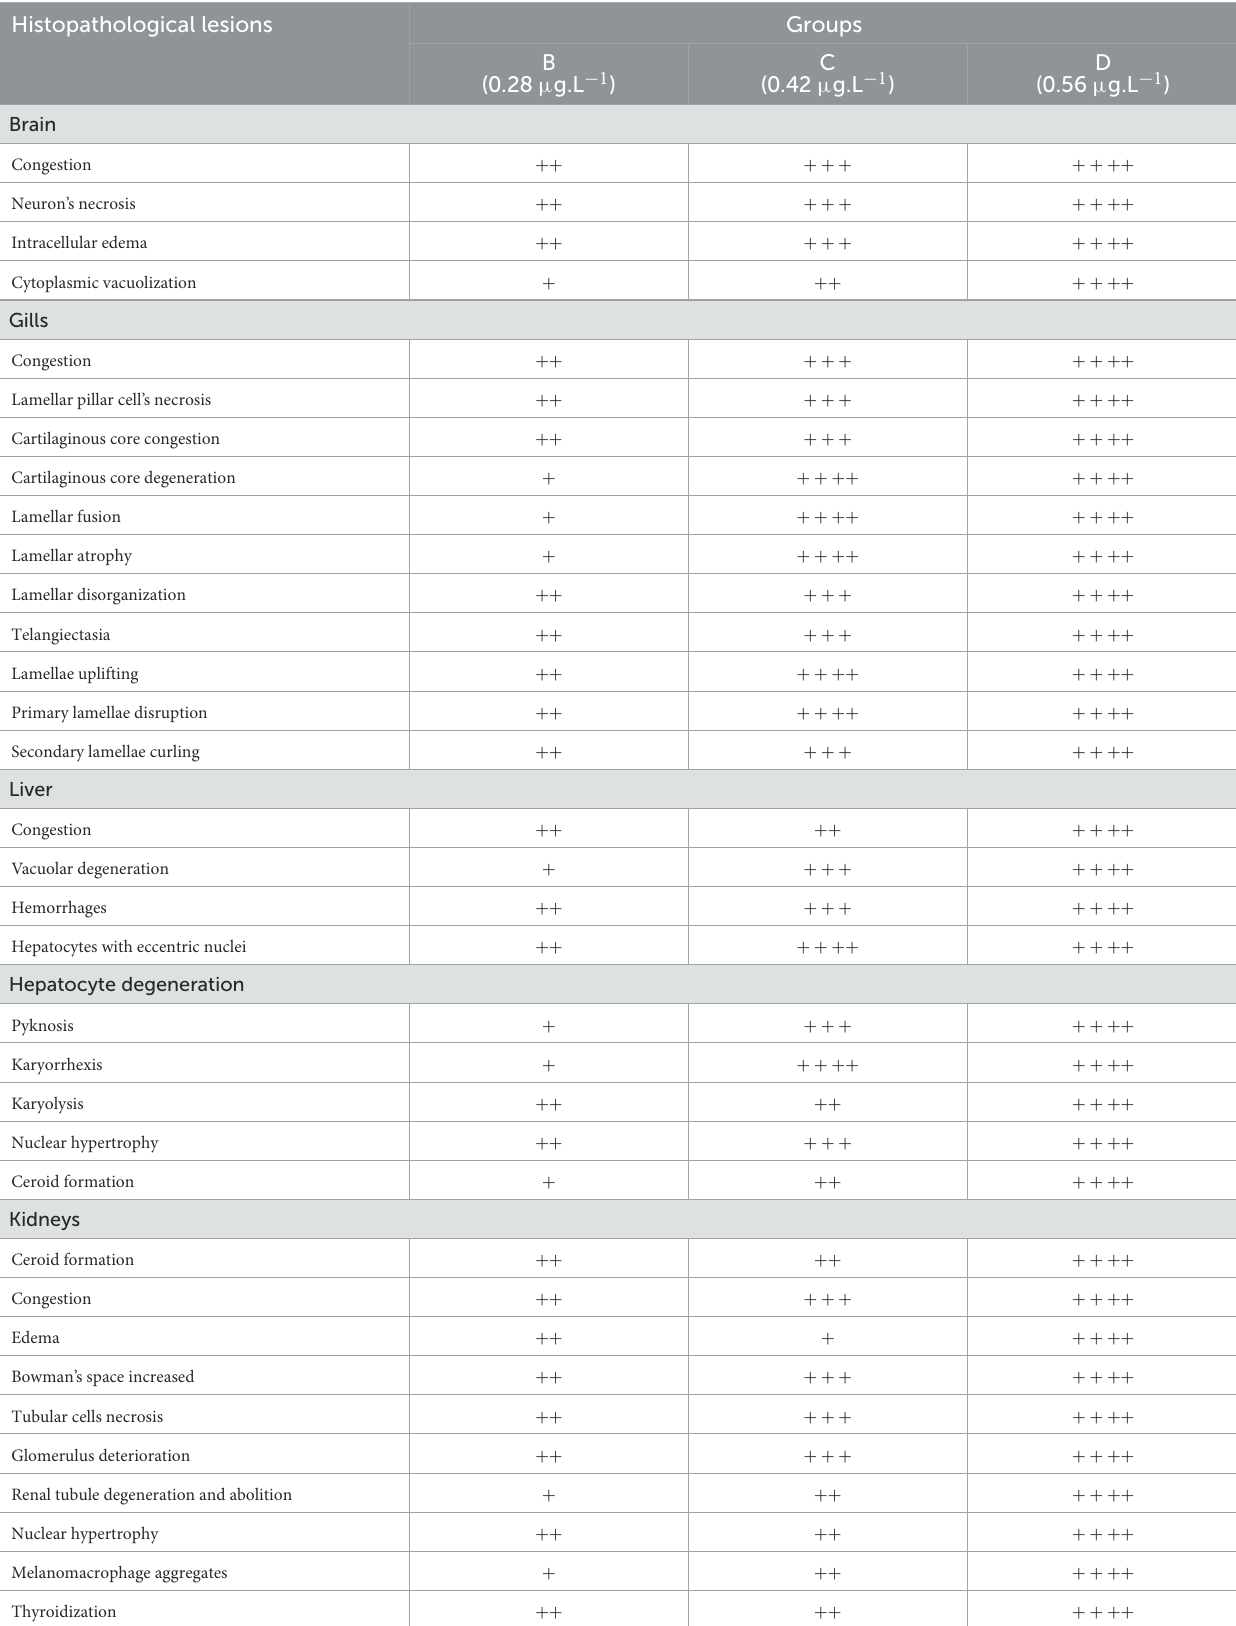
TABLE 8 Severity/degree of different histopathological changes in various tissues of Labeo rohita exposed to various concentrations of copper sulfate at day 24th. Histopathological